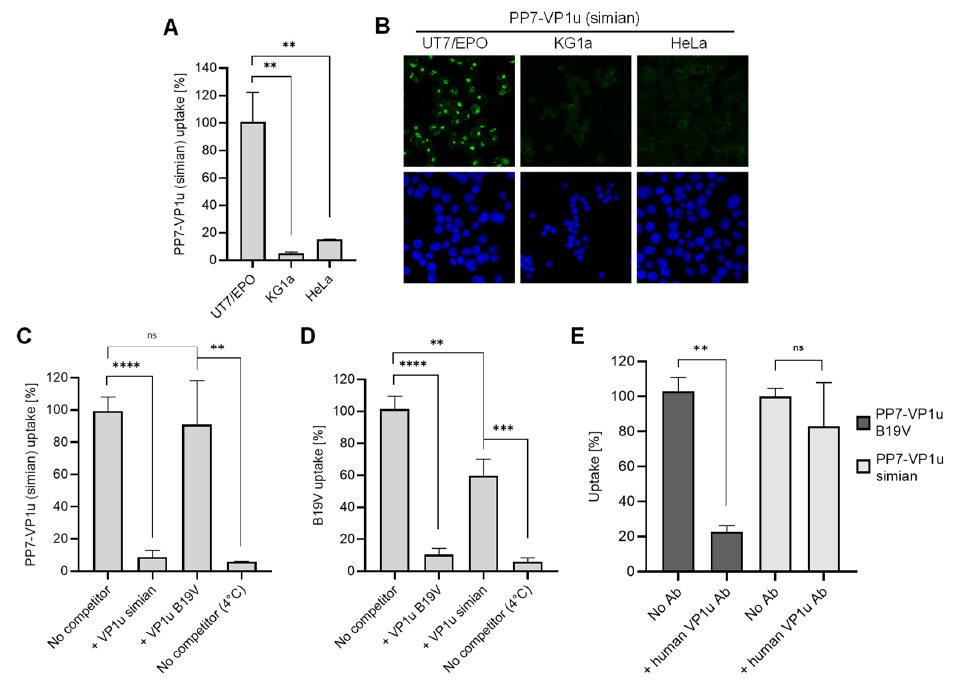
Figure 6. Uptake of simian PP7-VP1u into human cells. Simian PP7-VP1u was incubated with UT7/Epo, KG1a, and HeLa cells for 30 min at 37 °C. The internalized constructs were quantified by RT-PCR ( A ) and detected by fluorescence confocal microscopy ( B ). ( C , D ) Internalization of simian PP7-VP1u and native B19V into UT7/Epo cells in the presence of competitors. Samples incubated without competitors at 37 °C and 4 °C served as a reference for maximal internalization and com- plete block, respectively. ( E ) B19V and simian PP7-VP1u internalization into UT7/Epo cells was car- ried out in the absence or presence of a 200-fold molecular excess of MAb 1418-1 against B19V VP1u. Internalized bioconjugates were quantified by RT-PCR. The quantitative RT-PCR results are pre- sented as the mean ± SD of three independent experiments. **** p < 0.0001; *** p < 0.001; ** p < 0.01; ns, not significant.